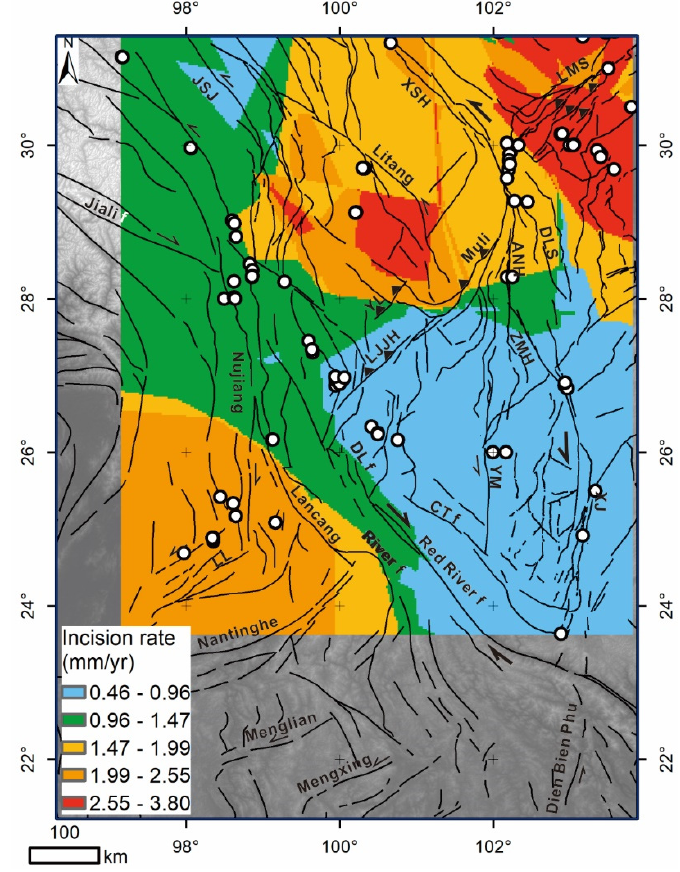
Figure 7. Interpolated incision rates derived from fluvial terrace dating (Data compiled from Tao et al. [63]).